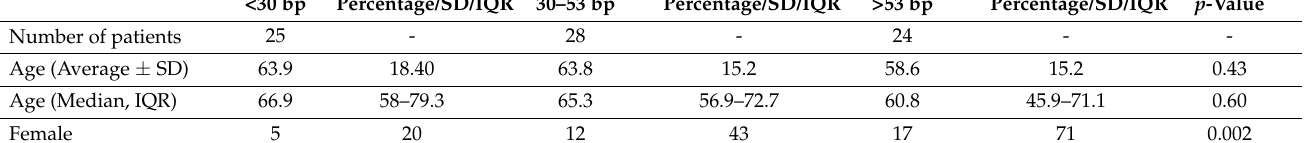
Table 1. Baseline characteristics of patients with FTL3 -ITD mutations, categorized by base-pair insertion